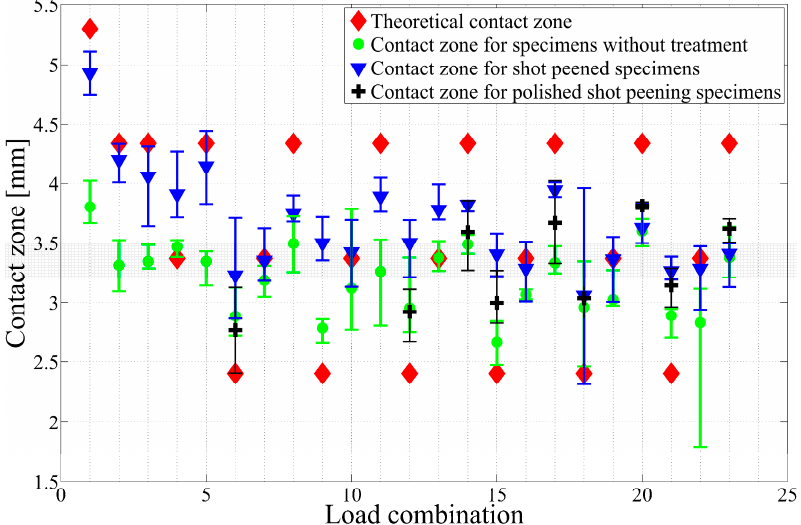
Figure 14. Total contact width in each test of each group and theoretical values given by Hertz’s theory.